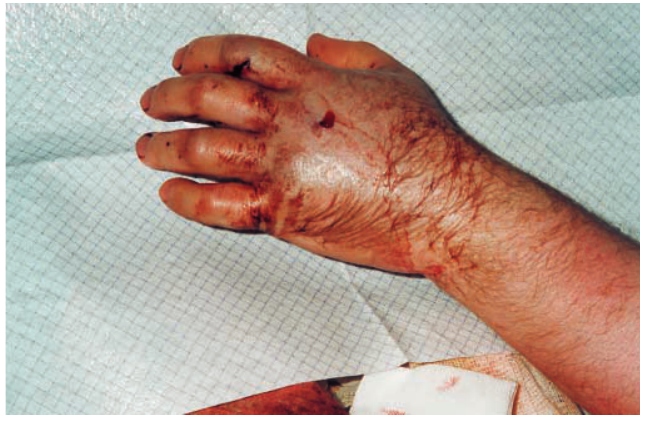
Figure 2 Progressive swelling and incipient necrosis on the dorsum of the left